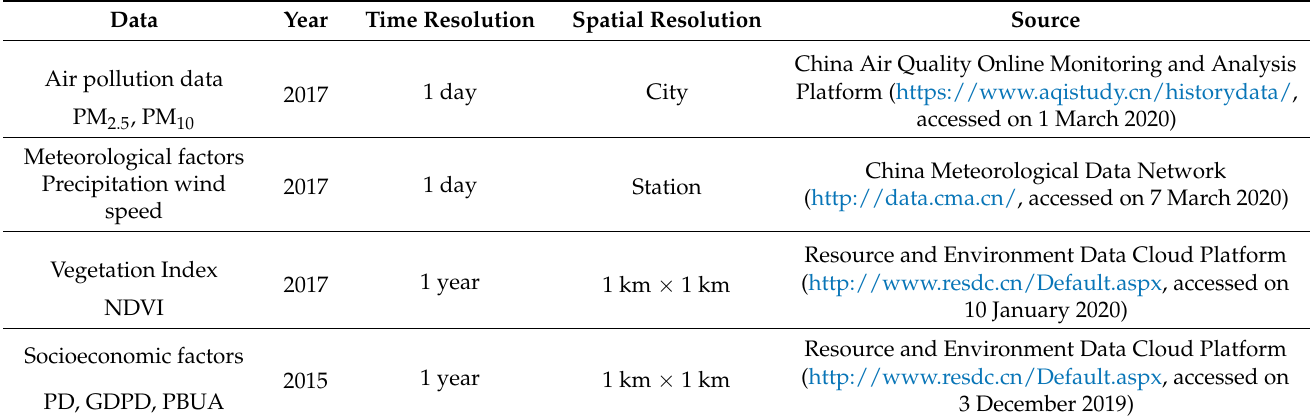
Table 1. List of data sources used in the current